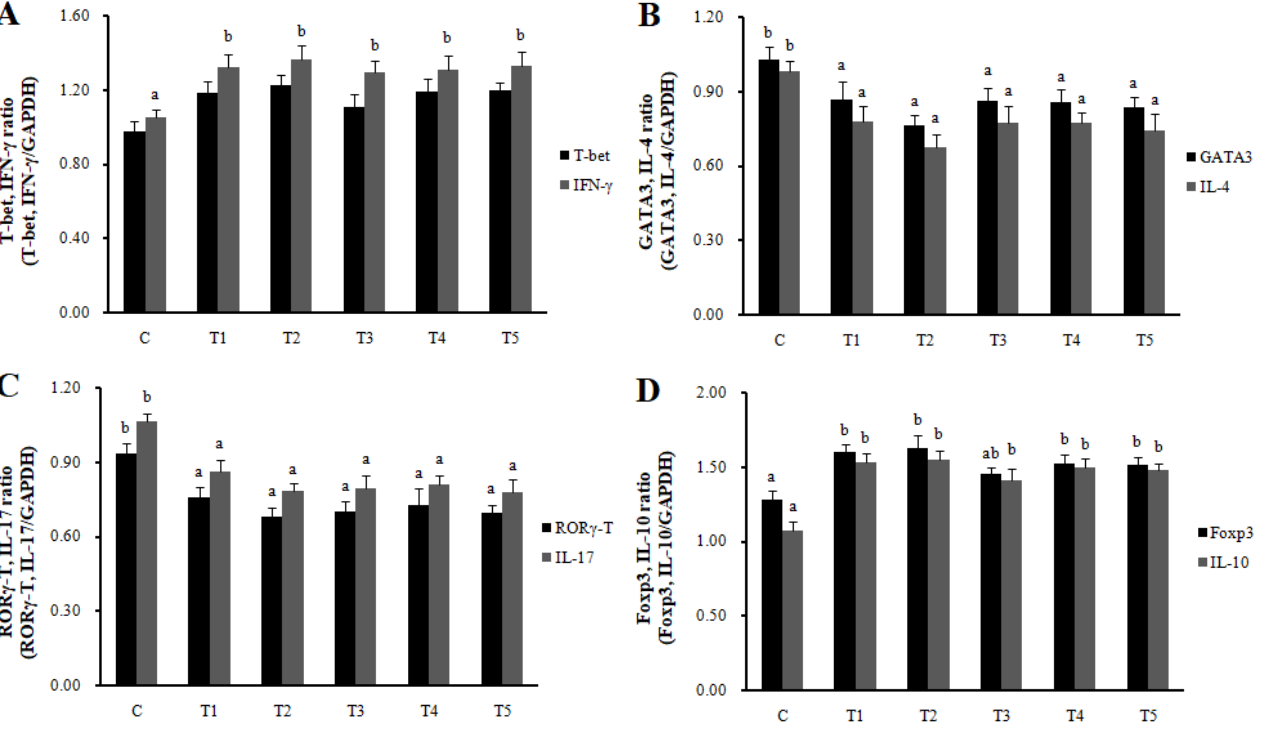
Figure 3. Th1, Th2, Th17, and Treg cells transcription factors and cytokines expression in spleen by real-time reverse transcriptase polymerase chain reaction analysis. Data represent means±standard deviations of 8 replicates. RC -LAB, Rubus coreanus -derived lactic acid bacteria; T-bet, T-box expressed in T cells; IFN-γ, interferon-gamma; GATA 3, GATA binding protein 3; IL-4, interleukin-4; RORγT, RAR-related orphan receptor gam - ma T; Foxp3, forkhead box P3; C, control; T1, 1% RC -LAB fermented feed; T2, 2% RC -LAB fermented feed; T3, 2% L. plantarum ; T4, 2% L. acidophi- lus ; T5, 2% B. animalis . T-bet, IFN-γ (Th1, A), GATA-3, IL-4 (Th2, B), RORγT, IL-17 (Th17, C) and Foxp3, IL-10 (Treg, D). a-c Means are significantly dif - ferent within the same row (p<0.05).